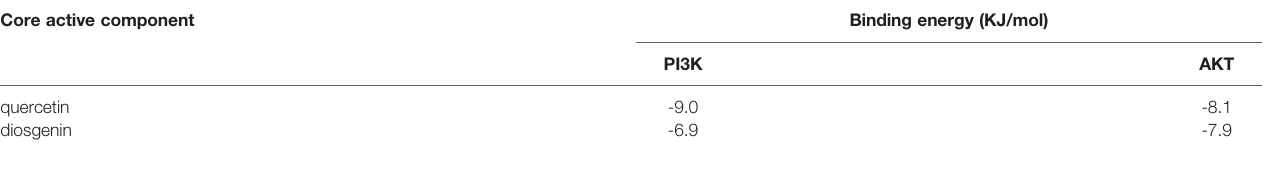
TABLE 4 | The binding energy of key molecules and core targets. Core active